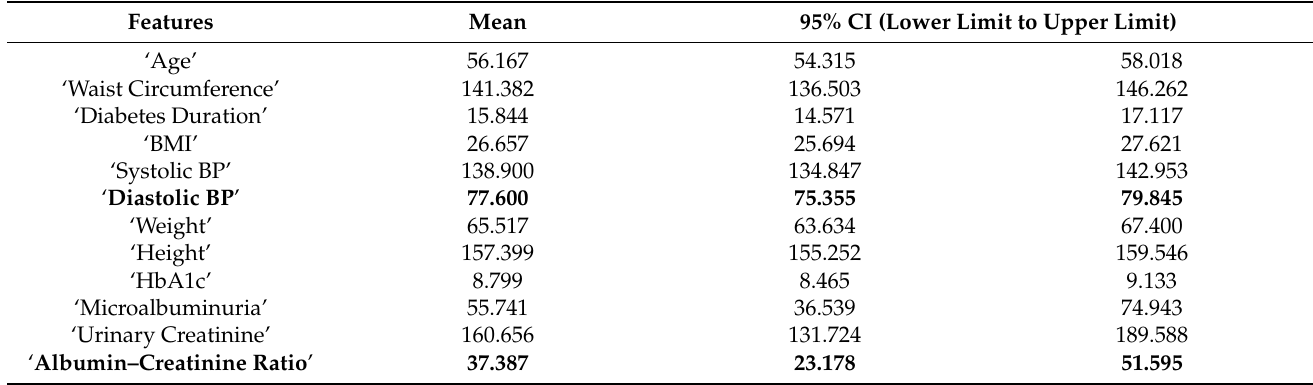
Table 6. 95% Confidence intervals for cardiac autonomic neuropathy patients (categorical features, such as gender, smoking history, and smokeless tobacco history, have been omited from the table);. The subject count is 75 (65 pCAN, and 10 nCAN patients), and the features that are used in the model classifier are marked in bold text.